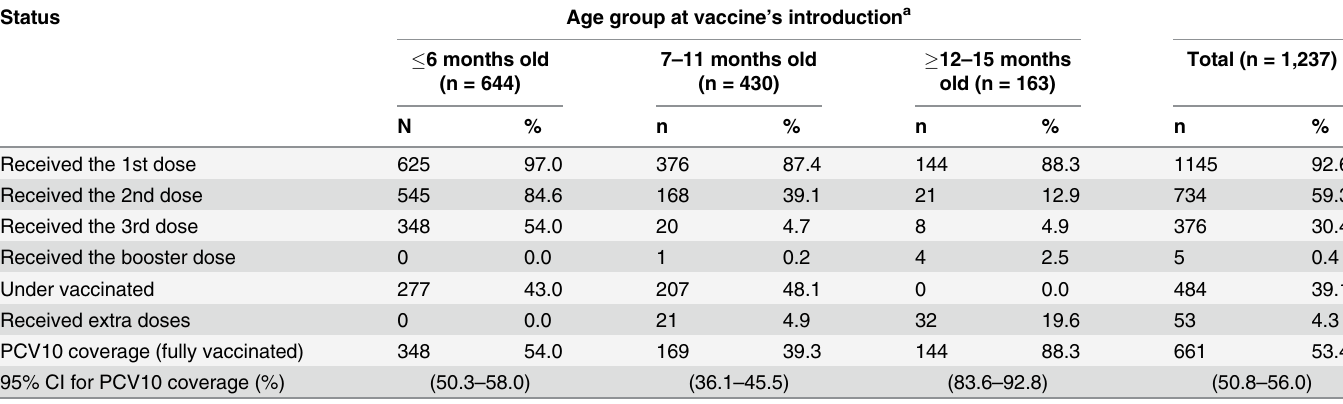
Table 1. Vaccination status according to doses and age groups, 6 to 8 months after PCV10